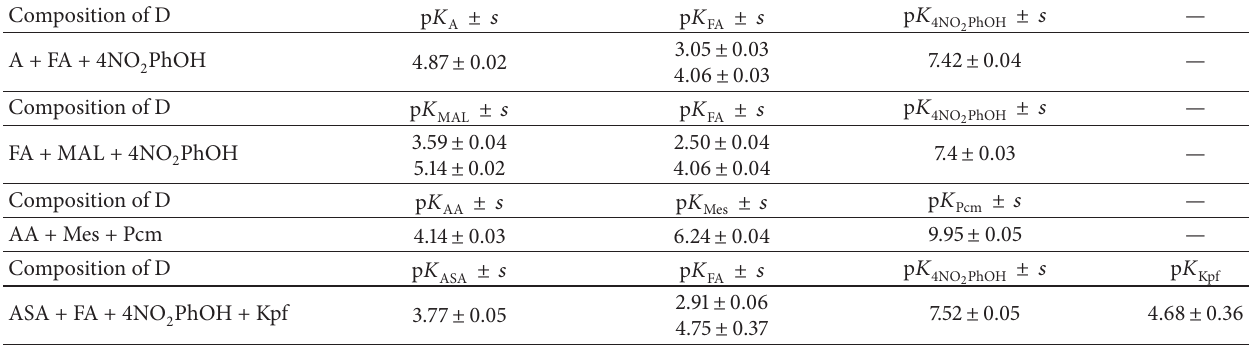
Table 8: The p 𝐾 ’s values of compounds determined in the multicomponent mixture of phenol and enol OH–acids together with other weak a electrolytes at 25 ∘ C.